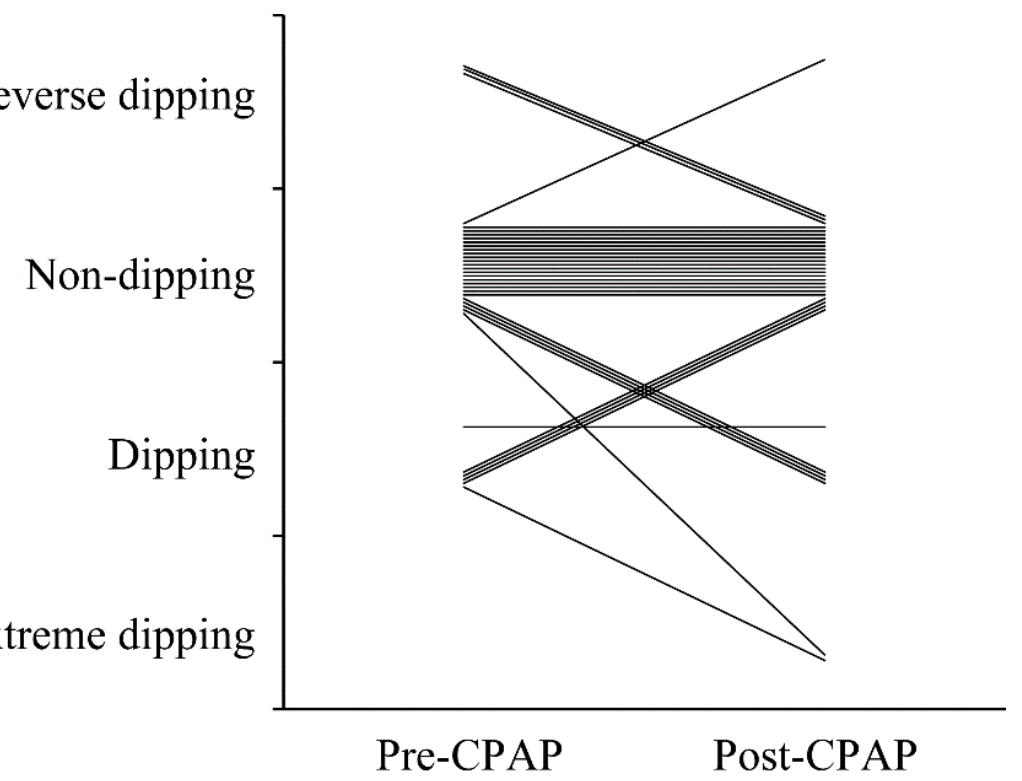
Figure 2. A comparison between blood pressures and NBPFs pre- and post-CPAP. ( A ) REM sleep. ( B ) Non-REM sleep. Gray and white bars indicate the values pre- and post-CPAP, respectively. Values are presented as means ± SDs; error bars represent SD. CPAP, continuous positive airway pressure; DBP, diastolic blood pressure; NBPFs, nocturnal blood pressure fluctuations; SBP, systolic blood pressure; SD, standard deviation.